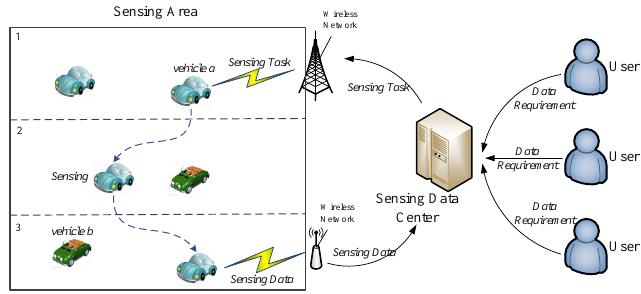
Figure 1. Architecture of vehicular mobile crowd sensing systems.